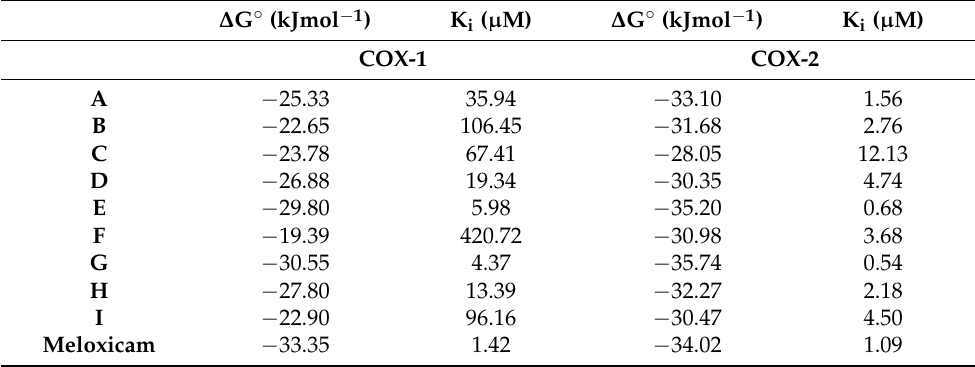
Table 4. Theoretical binding free energy and inhibit constant for interactions studied compounds with COX-1 and